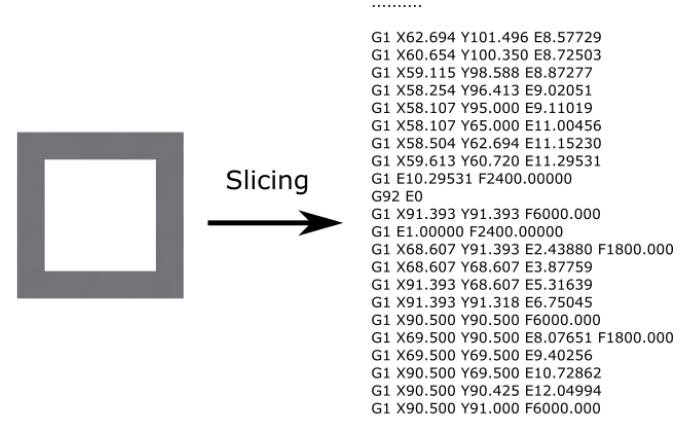
Figure 14. Generation of the g-code.